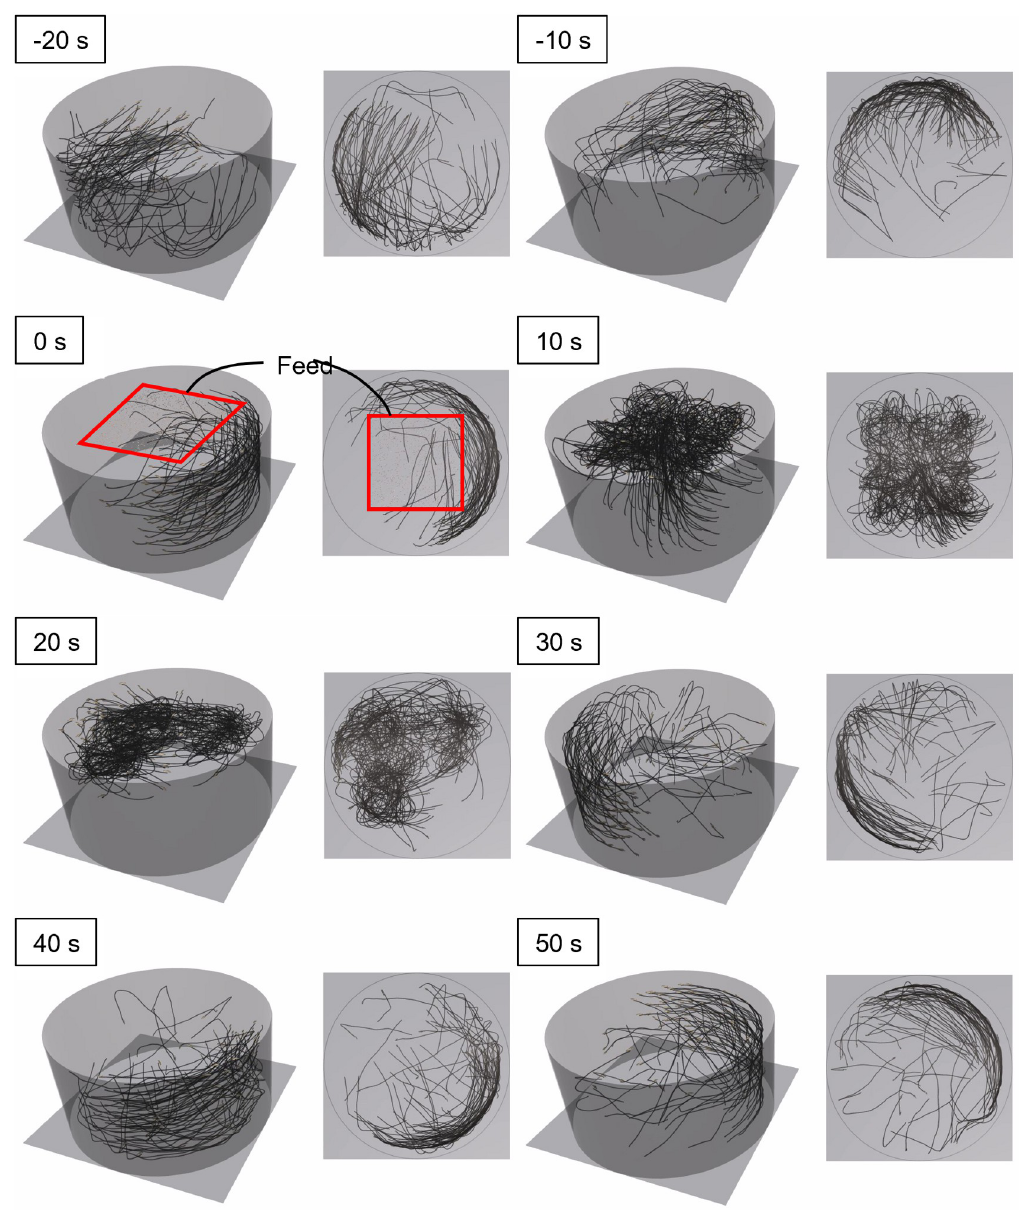
Fig 6. Individual movement paths for the Feeding A group. The elapsed times from the initiation of feeding are indicated.